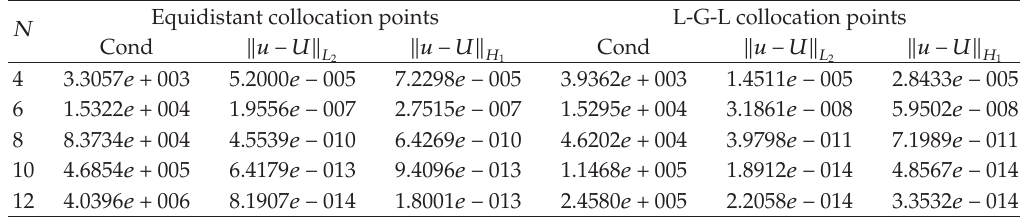
(cid:4) 100, β (cid:4) 10 (cid:6) 1 2